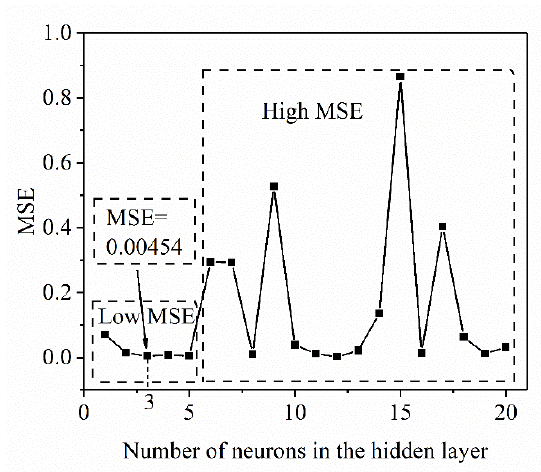
Figure 7. Effect of the number of hidden layer neurons on the prediction accuracy of the DRX grain size model.